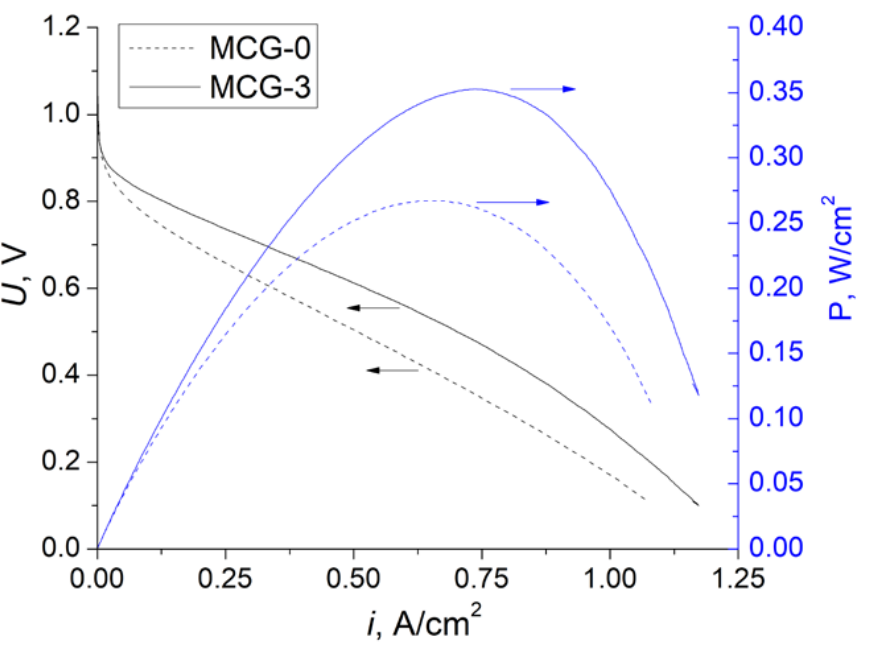
Figure 6. Voltammetric curves and dependences of the power density on the current density for MEAs with MCG-0 and MCG-3 membranes. The characteristics were measured at 65 °C and 100% gas RH. Arrows point to the respective Y-axes.